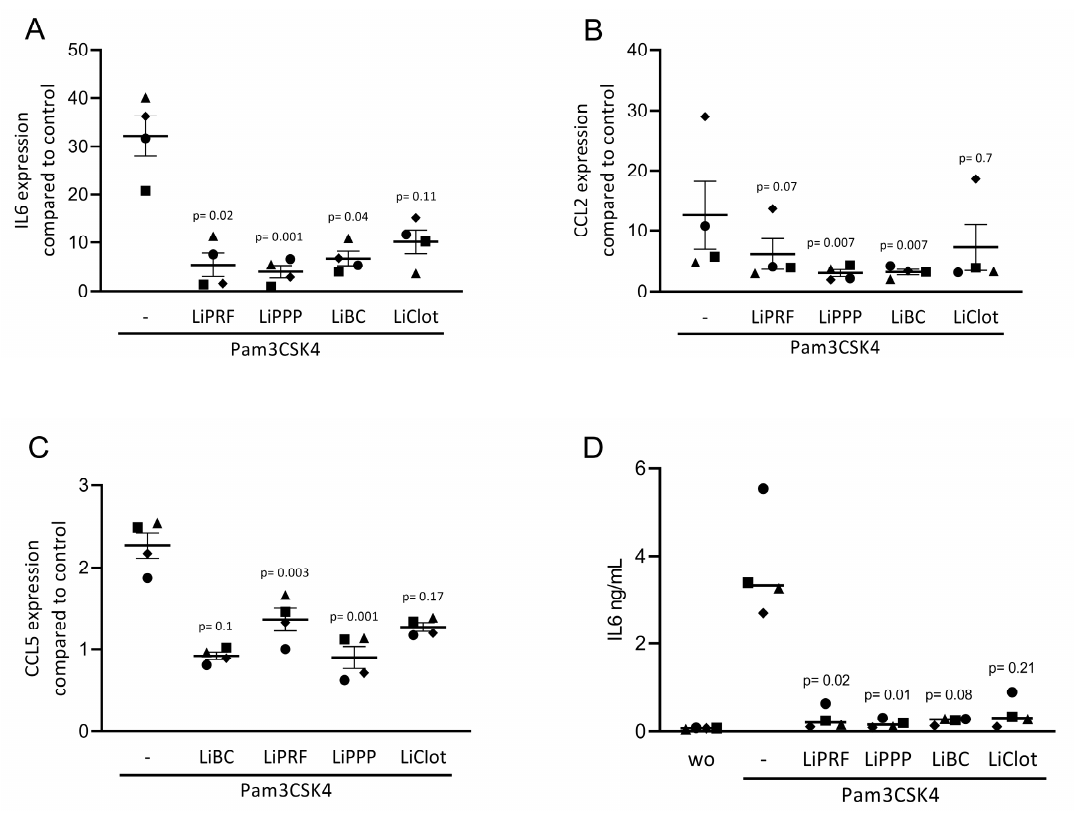
Figure 3. Lipids from PRF can reduce inflammation provoked by TLR2 agonists in ST2 cells. The ST2 cells were exposed to 20% LiPRF, LiPPP, LiBC and LiClot in the presence of 5 µg/mL Pam3CSK4, an agonist of TLR2. ( A – C ) Data show the x-fold changes in IL6, CCL2 and CCL5 gene expression and ( D ) the concentration of IL6 in the supernatant of ST2 cells. Each data point represents an independent experiment. N = 4. For comparison of groups, the Friedman test was applied. WO means without and represents unstimulated cells.